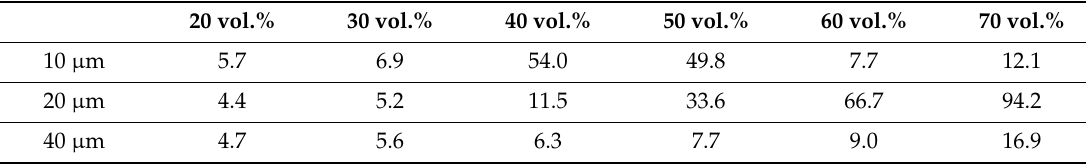
Table 3. Degree of nitridation of the 0–70 vol% SiC (10–40 µ m) / 6061Al composites heated at 650 ◦ C for